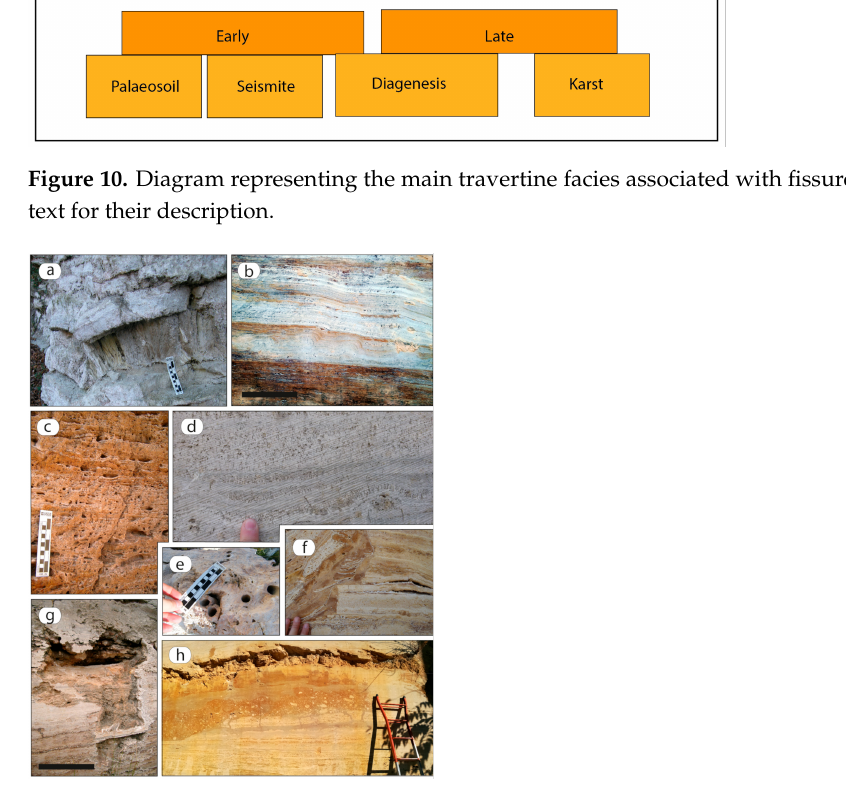
Figure 11. ( a ) Example of crystalline facies formed by dentritic, feather-like calcite crystals (Bagni San Filippo, Italy); ( b ) section of gently undulating, terraced, low-angle slopes with a dominant porous fabric formed by alternation of laminar microbialites (bindstone, dendrolite, and crustone) locally associated with crystalline ones (typically foam and raft) (Akkoy, Turkey ) (black scale = about 40 cm); ( c ) example of highly porous laminar microbialites from a low-angle slope of Bagni San Filippo (Italy); ( d ) section of a small pool filled with alternation of crustones and microbialites (flowing water toward the left—Rapolano terme, Italy); ( e ) autochtonous encrusted skeletal grain (coated stems in the life position) often observed in a distal environment (Cambazlı, Turkey); ( f ) lateral passage from a fracture (on the left) and bedded travertine (alternation of crustones and microbialite—on the right). Notice the deformation of the bedded travertine and the secondary white cements developed in the opened voids (Akkoy, Turkey); ( g ) example of a karstic feature filled with secondary deposits (speleothems and terrigenous deposits) commonly developing in the late evolutionary stage (Bagno Vignoni, Italy) (black scale = about 70 cm); ( h ) example of seismically induced, soft sediment deformation structures from Rapolano Terme